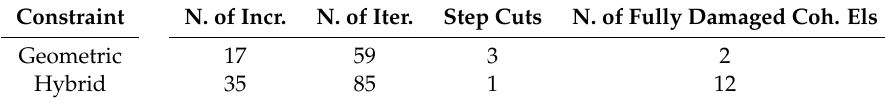
Table 3. Summary of numerical performance for the perforated cantilever